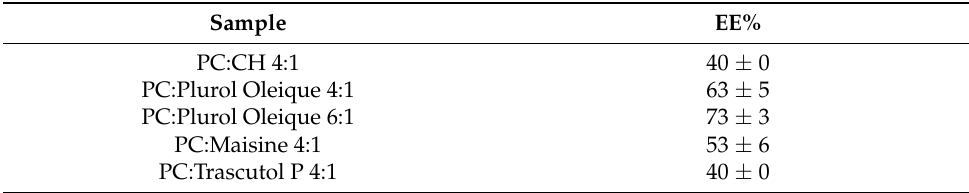
Table 2. Encapsulation efficiency (EE%) of different liposomal formulations (Mean ± SD, n = 3). PC: phosphatidylcholine, CH: